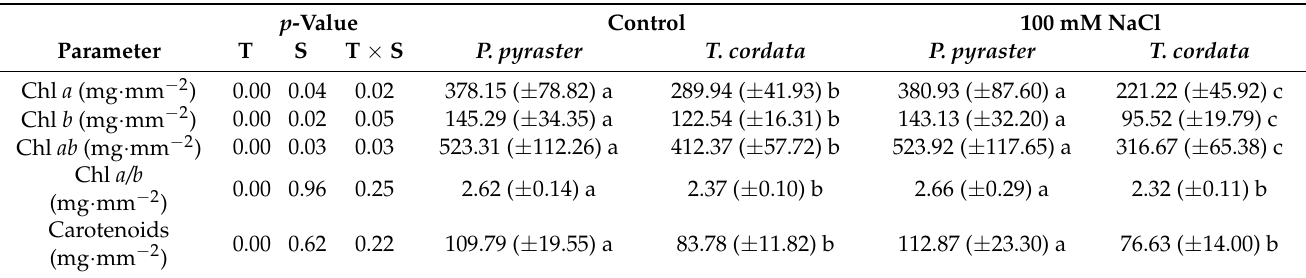
Table 3. The contents of photosynthetic pigments in the leaves of P. pyraster and T. cordata seedlings after 50 days of salt treatment. Mean values followed by different letters are significantly